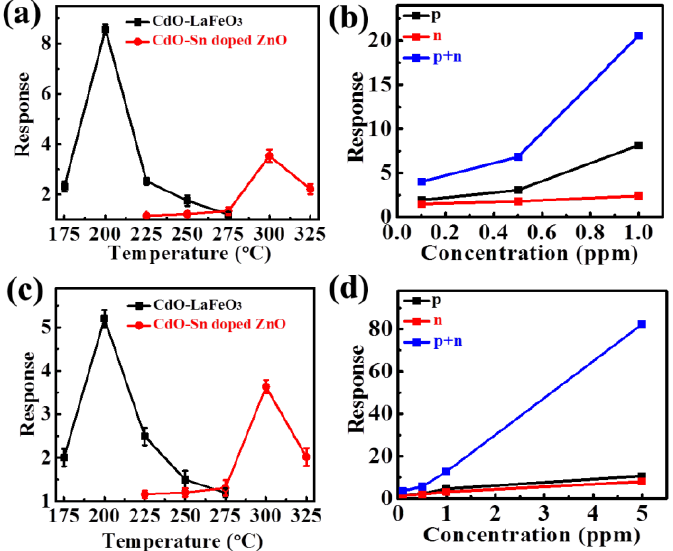
Figure 7. Responses of CdO-activated LaFeO 3 and Sn-ZnO: ( a , b ) relationships of ethanol response with working temperature and concentration, respectively; ( c , d ) relationships of acetone response with working temperature and concentration, respectively.